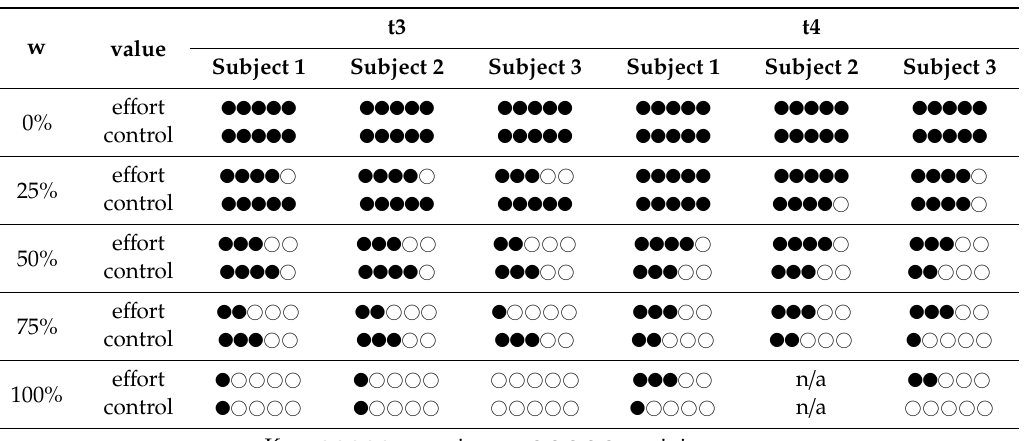
Table 5. The results of the questionnaire conducted among the test subjects on the e ff ort during wheelchair propulsion and the degree of control over the wheelchair depending on the value of the assistance amplification coe ffi